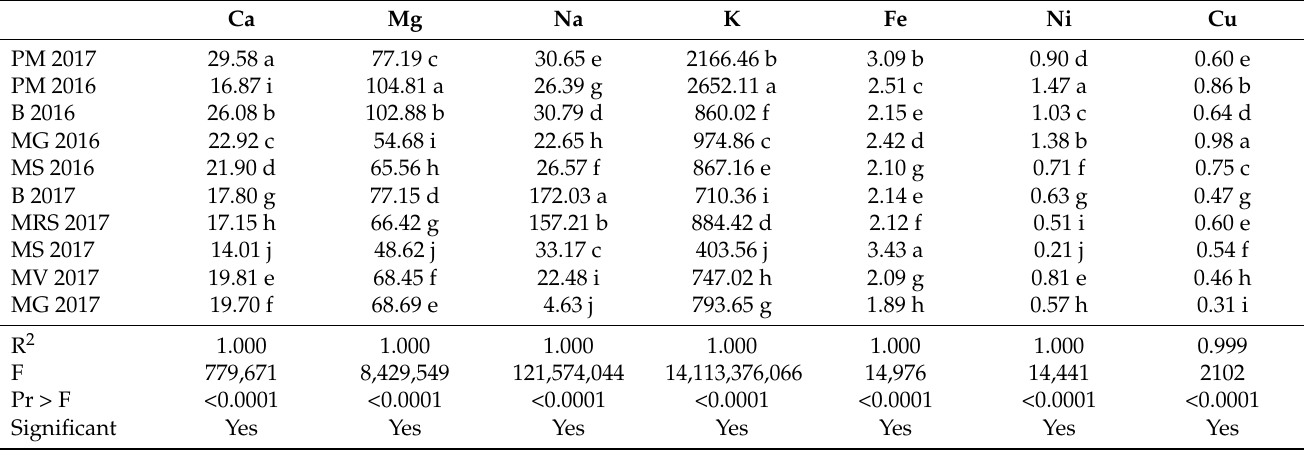
Table 6. Macro and micronutrients content in different chestnut fruits ( Castanea sativa Mill) harvested in 2016 and 2017 (mg/100 g